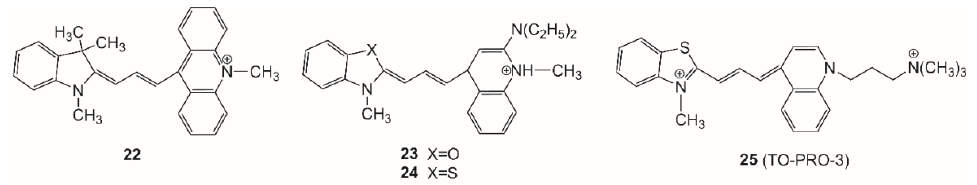
Figure 7. Structures of cationic unsymmetrical trimethine cyanines 22 – 25 . A number of unsymmetrical cyanine dyes with a quinoline heterocycle (in particular, trimethine cyanines 23 , 24 ; Figure 7) were synthesized, and their properties as spectral ‐ fluorescent probes for dsDNA were evaluated [35]. For a number of the dyes, high Φ